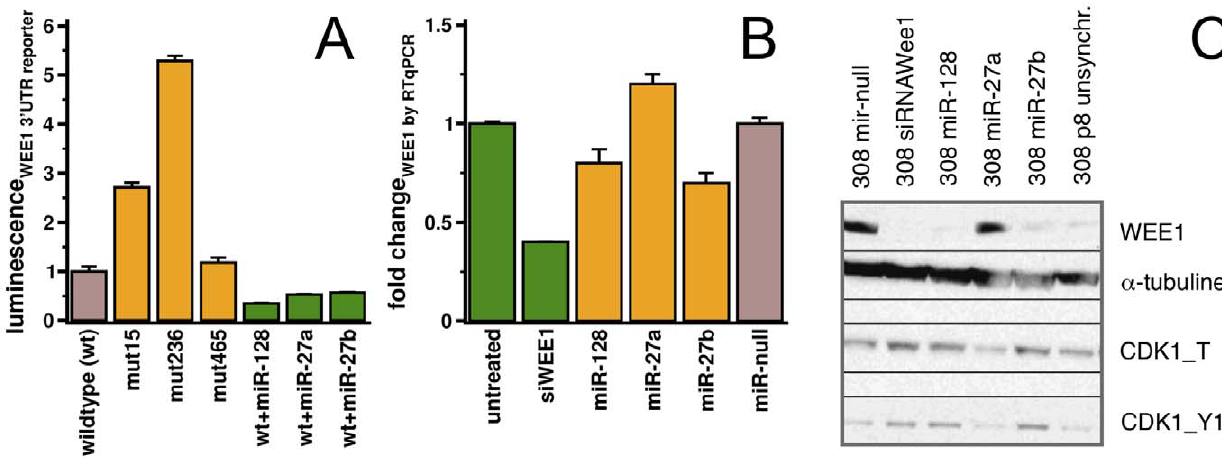
Figure 6. Effects of significantly associated miRs on WEE1 expression. ( A ) miRs-128/27a/27b that are under-expressed in glioma were transiently over-expressed in TIC308 cells with corresponding pEp-miR-expression vectors. Co-transfecting this cells with a luciferase reporter constructs that contained the whole UTR region of WEE1, we observed decreasing luciferase activity (brown/green bars). Furthermore, co- transfection with reporters containing mutated sequences of seed regions in the three potential binding sites around nucleotides 15, 236 and 465 of the WEE1 3 9 UTR (yellow bars) showed an increase in luciferase activity when binding sites 15 and 136 of miR-128/27 were mutated. However, we did not find an effect when position 465 was mutated where binding of the naturally over-expressed miRs-302/372/93 was predicted. Our results allowed us to conclude that miRs-128/27a/27b indeed bind the 3 9 UTR of WEE1, and their low expression in gliomas potentially plays a crucial role in the high levels of WEE1 expression in these tumors. ( B ) Similarly to silencing WEE1 with a corresponding siRNA, ectopic expression of miR-128 and miR-27b reduced WEE1 mRNA and protein levels in synchronized cells of TIC308. ( C ) Downstream effects of WEE1 modulation by miRs was observed as CDK1_Y15 phosphorylation is similar compared to when WEE1 was directly down-regulated by a specific siRNA treatment. In particular, we observed that the recovery of miR-128 as well as over-expression of miR-27b constrained WEE1 expression.